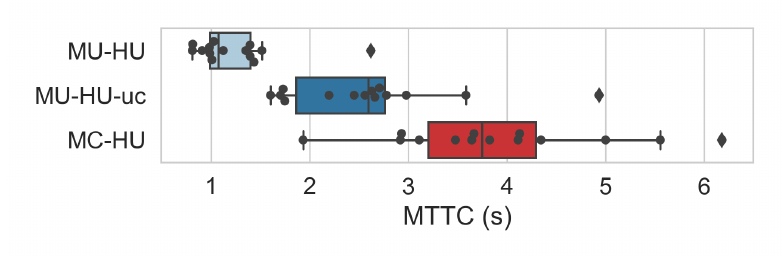
Figure 12. Minimum Time-to-Contact (MTTC) scores for human-uncertain conditions ( n =